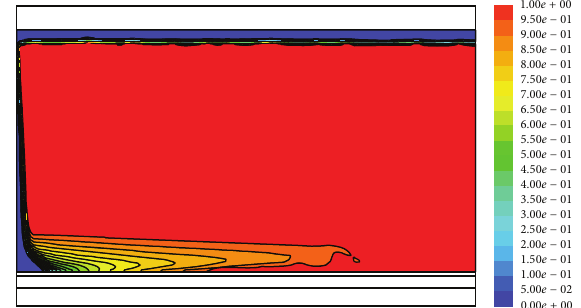
Figure 17: Distribution of solidified crude oil.